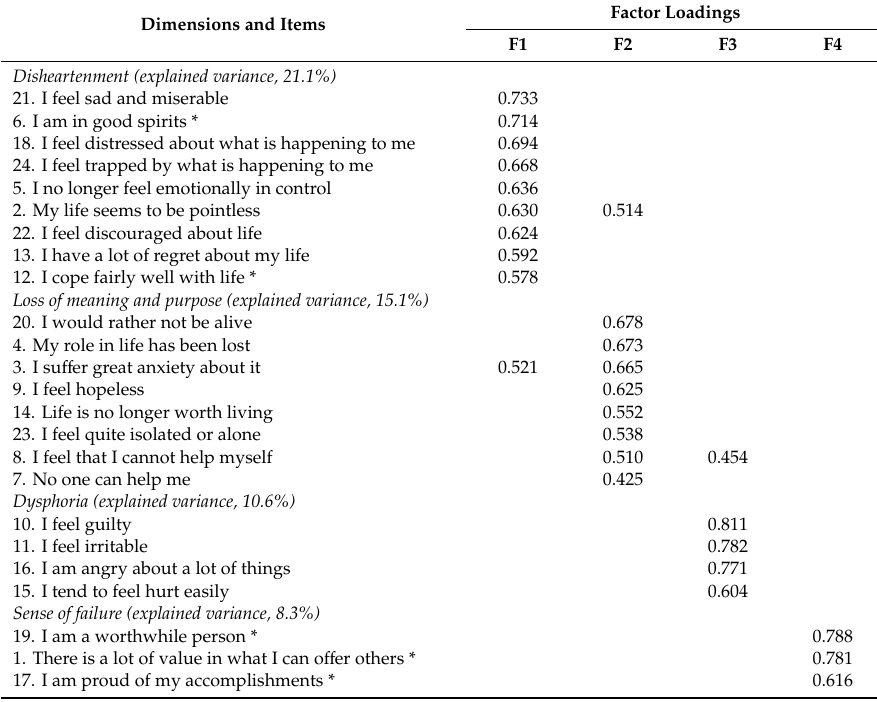
Table 4. Item and scale characteristics (principal component analysis, varimax-rotated 4-factor solution) of the Italian version of the Demoralization Scale in